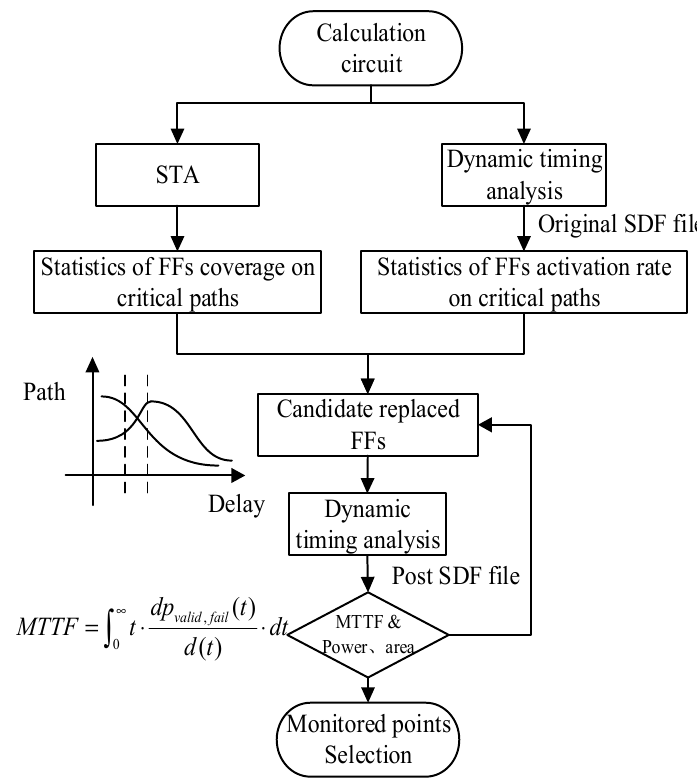
Figure 7. An automatic design flow of the proposed MAHS algorithm.